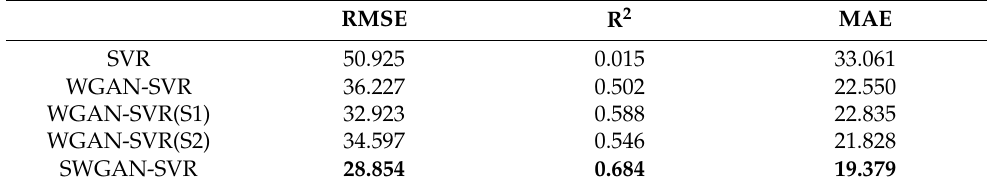
Figure 8. Total RMSE values of the different numbers of generated samples for the polyethylene process. Table 2. Performance comparison of SWGAN-SVR and other methods for industrial polyethylene.